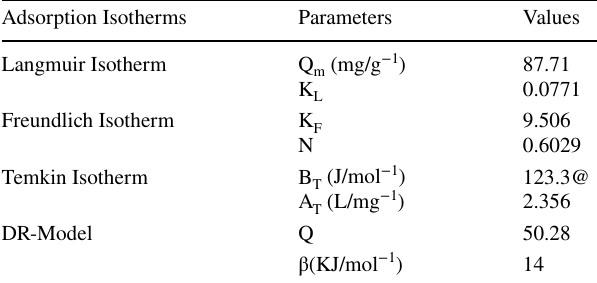
Table 3 Parameters of different adsorption isotherm models Adsorption Isotherms